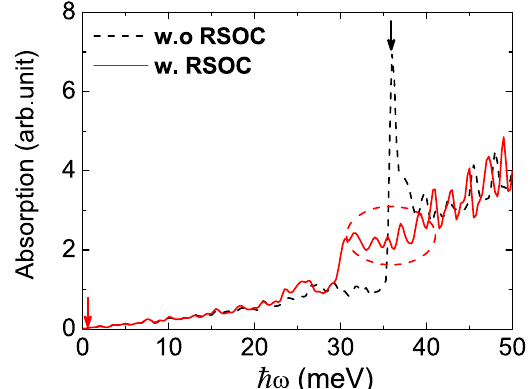
Figure 6. The optical absorption spectrum for the graphene magnetic supperlattice. Black dashed line without RSOC term; Red solid line with RSOC